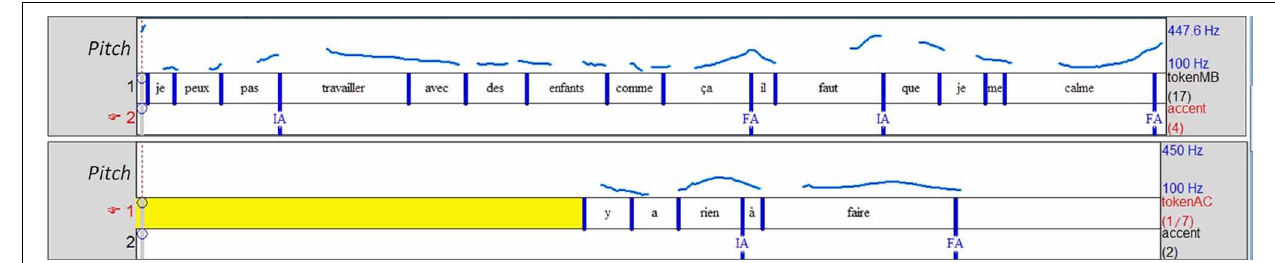
FIGURE 4 | Prosodic matching of the accentual arch (bounded by an initial accent IA or LHi and a final accent FA or H ∗ /L ∗ on part of the utterance). By using the same scale (100–550Hz for the different speakers) we can see that the storyteller (top two lines) is producing the same